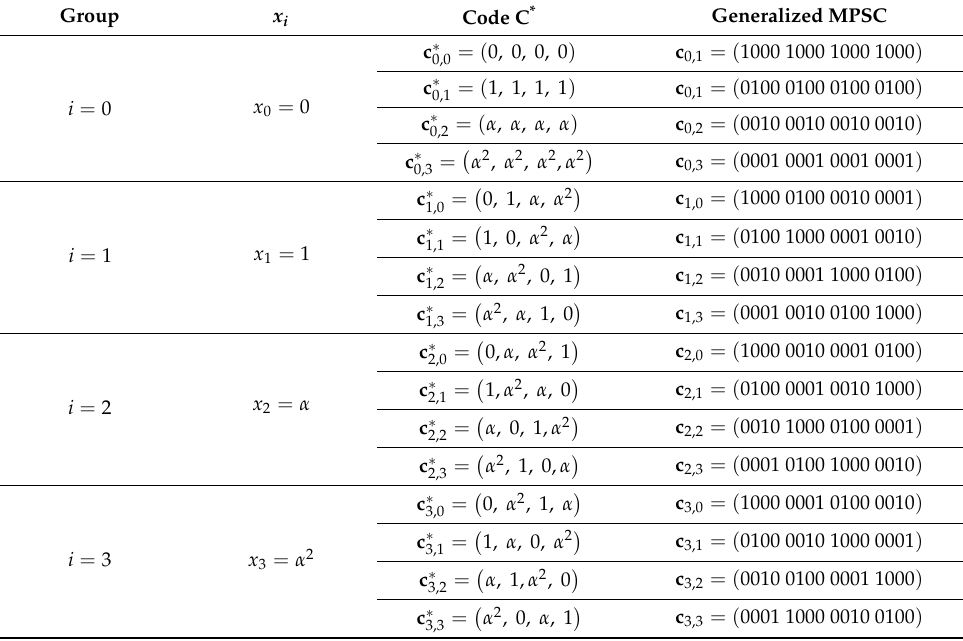
Table 1. An example of generalized MPSC ( q =